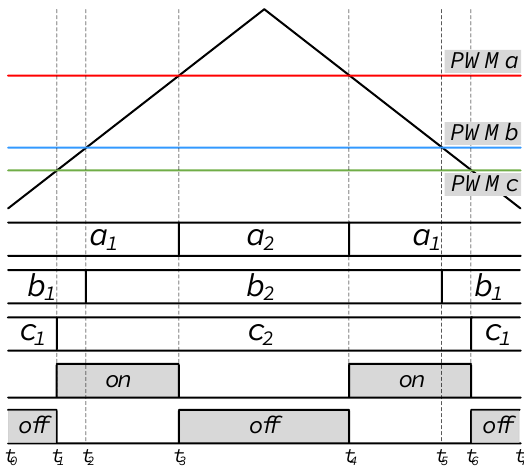
Figure 6. Switching modulation scheme describing on and off-state.